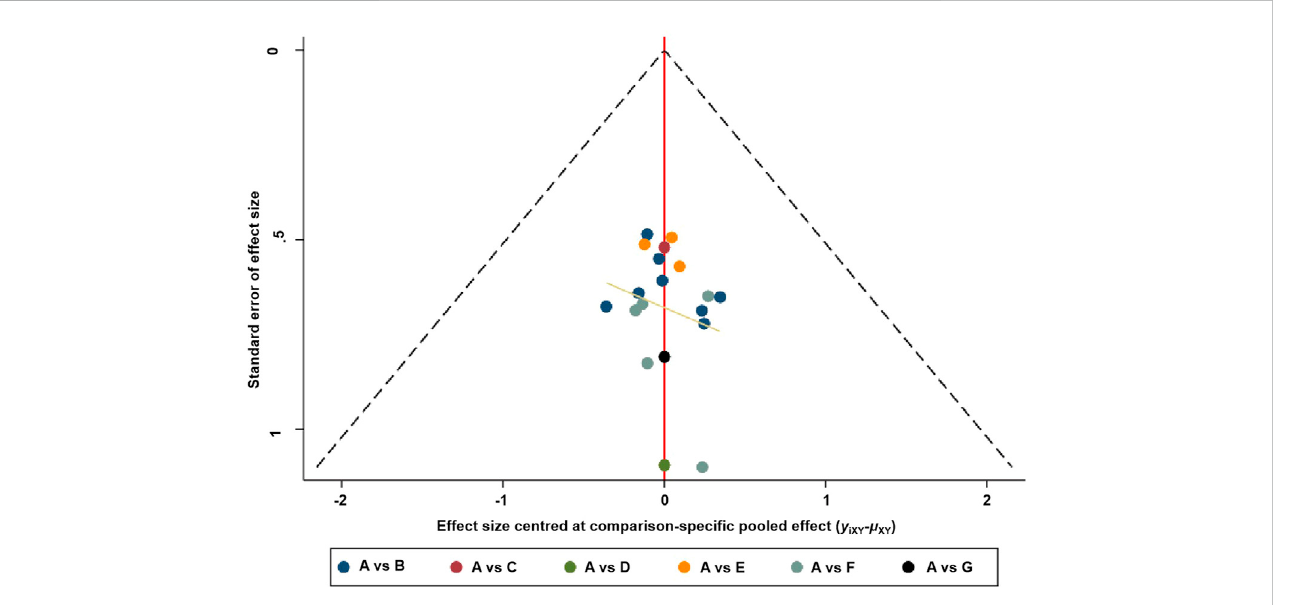
FIGURE 5 Funnel plot for clinical ef fi